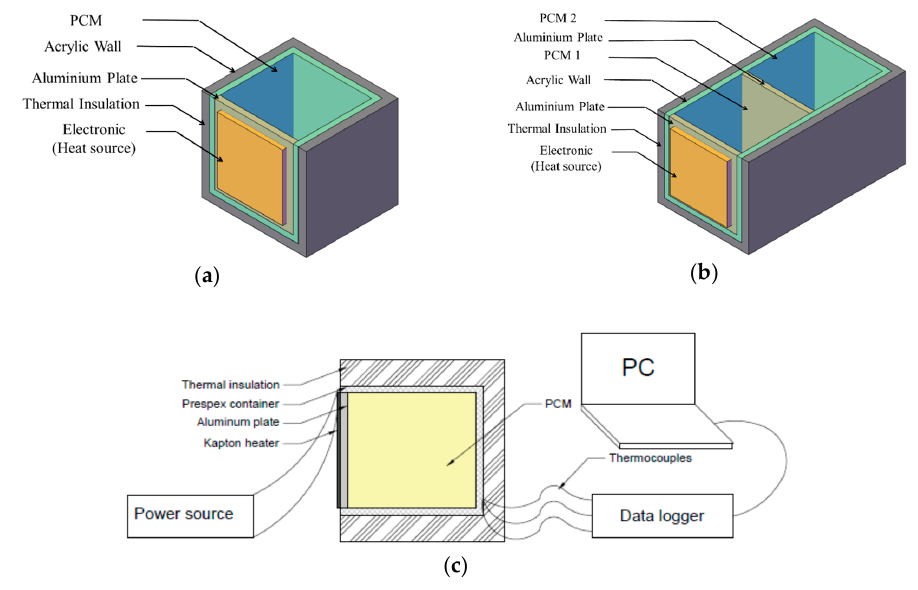
Figure 1. Schematic of the ( a ) heat sink A&B, ( b ) heat sink C and ( c ) experimental setup. PCM: phase change material.